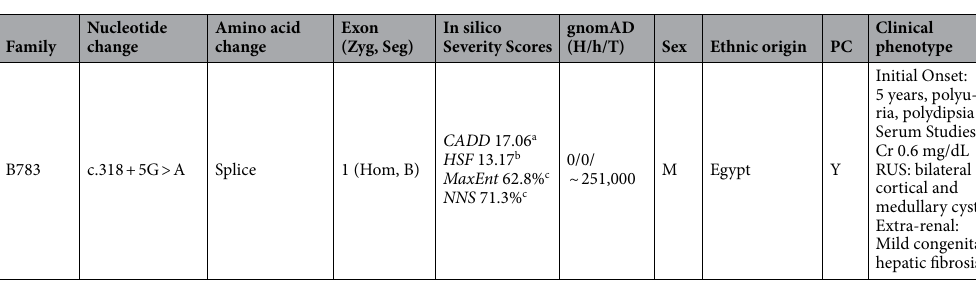
Table 1. Recessive variant in CYS1 in one family with cystic kidney disease. B, both parents appropriately heterozygous; CADD, Combined Annotation-Dependent Depletion prediction score; Cr, serum creatinine; gnomAD, Genome Aggregation database; H, homozygotes in gnomAD; h, heterozygous alleles in gnomAD; Hom, homozygous zygosity; HSF, HSF splice prediction score; M, male; MaxEnt, MaxEnt splice prediction score; NNS, NNSPLICE splice-site variant prediction score; PC, parental consanguinity; RUS, renal ultrasound; Seg, segregation; T, total alleles in gnomAD; Y, yes; Zyg, zygosity. a CADD scores between 10 and 20 are in the 1–10% most deleterious substitutions possible in human genome in terms of predicted effect on the gene product. b Predicts wildtype site broken by this change. c Percentage reflects expected reduction in splicing at this donor site as consequence of